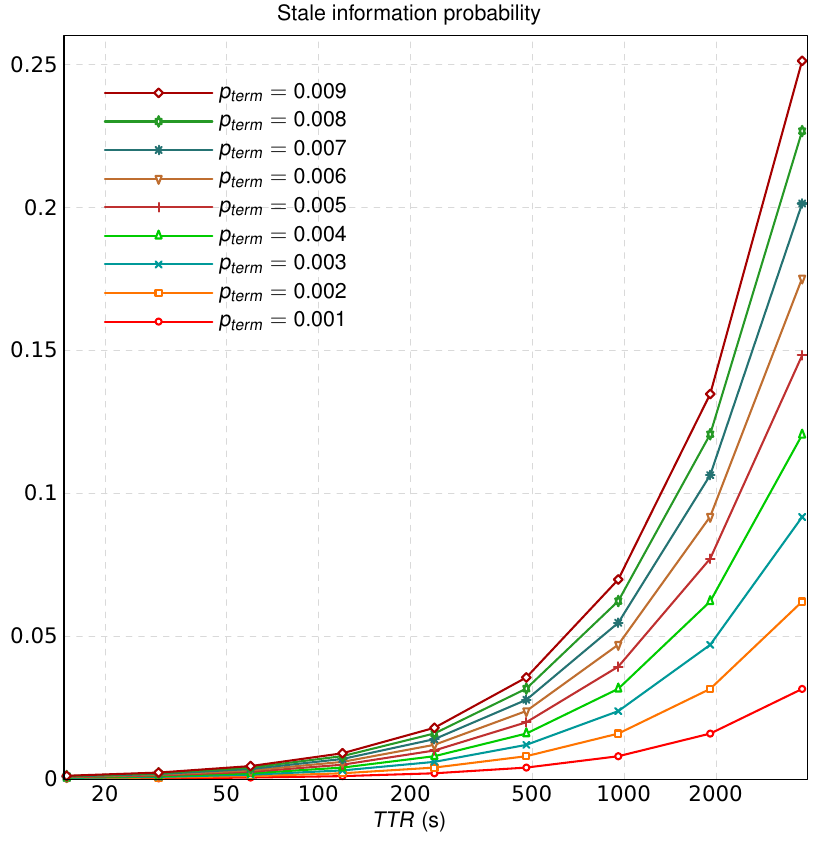
Figure 2. Probability of stale information in the overlay with the original